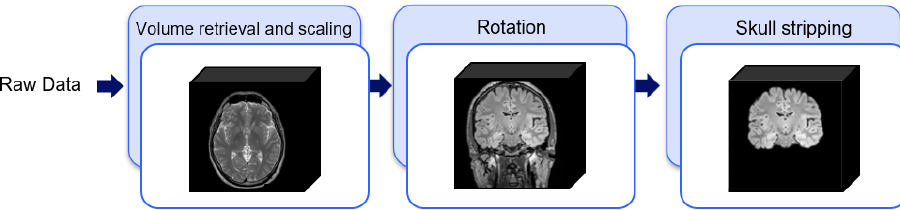
Figure 2. Illustration of the processes involved within the “Data Preparation” step.The volume retrieval and scaling create the 3D acquisitions with the isotropic dimension of 1 × 1 × 1 mm 3 ; the Rotation step creates a set of volumes in the sagittal projection; the Skull stripping removes the tissue outside the